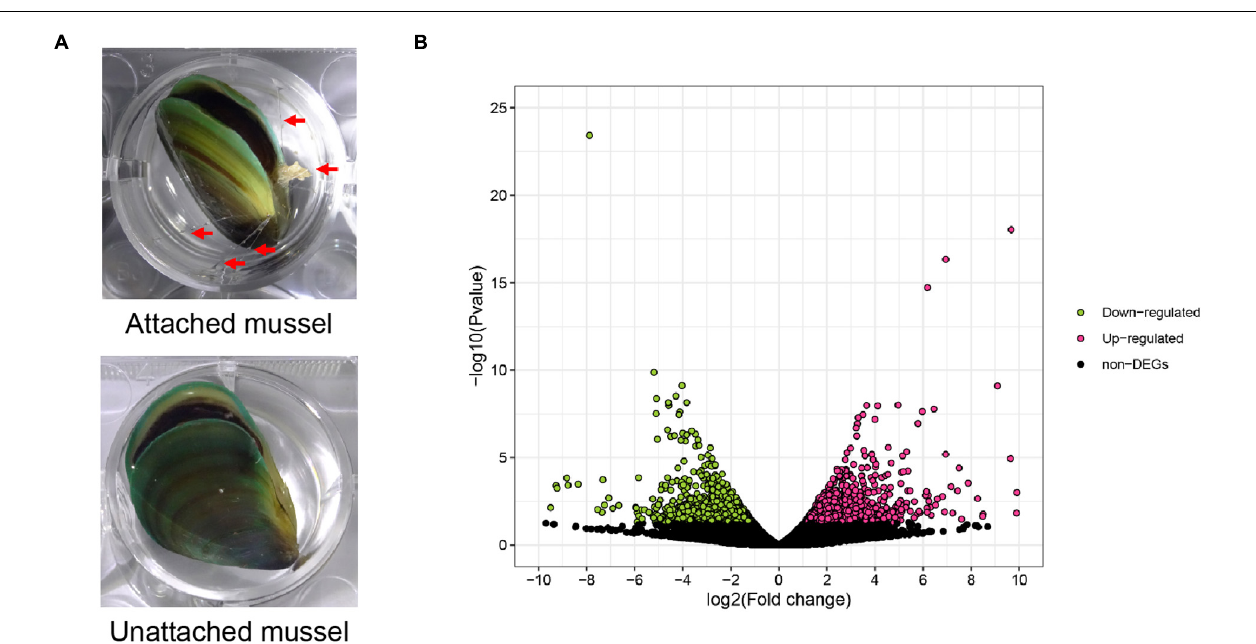
FIGURE 4 | Transcriptomic analysis of attached and unattached P. viridis . (A) The mussels attached 24 h after byssus thread removal (AT group for transcriptome analysis) and the mussels unattached 24 h after byssus thread removal (UAT group for transcriptome). Red arrows indicate byssus attachment sites. (B) Volcano plots of differentially expressed genes between AT and UAT mussels. Red and green spots indicate the up-regulated expressed genes and the down-regulated expressed genes between the AT and UAT groups, respectively. Black spots indicate genes that were not differentially expressed.